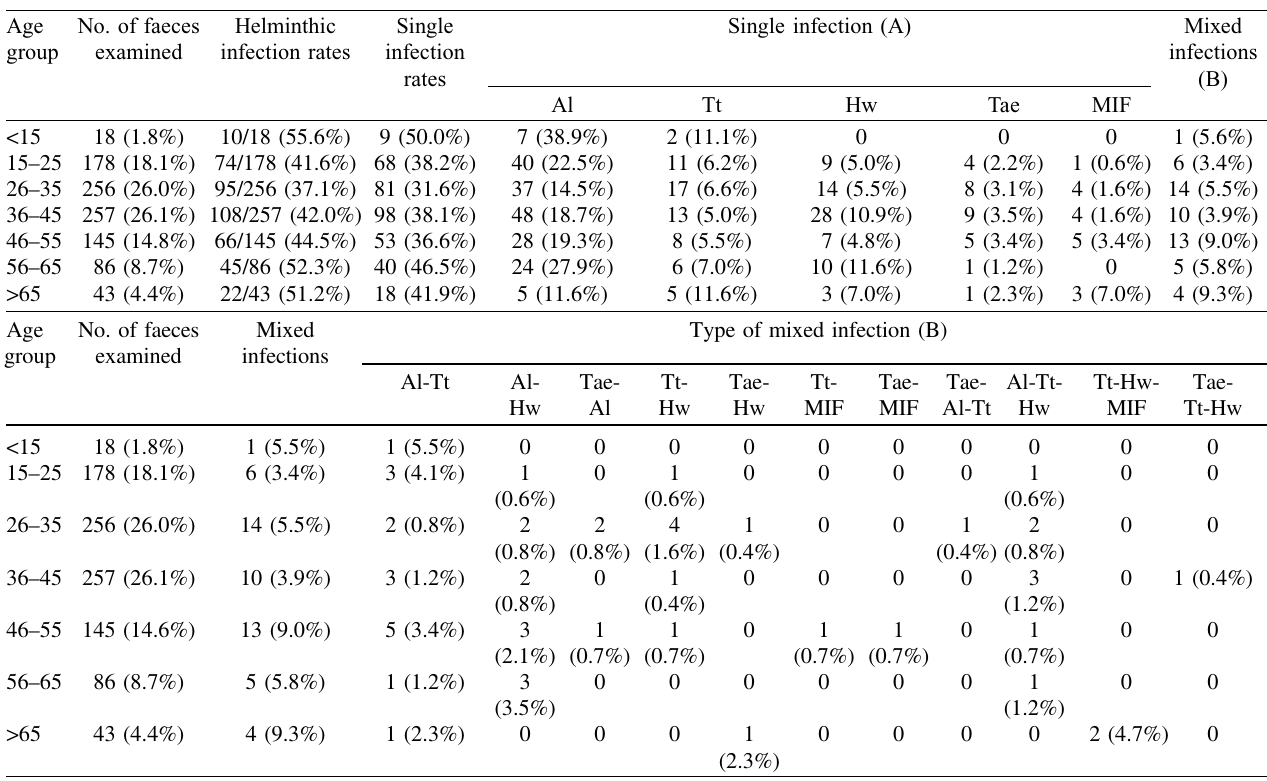
Table 2. Age distribution and prevalence of helminths in population. A and B are single and mixed infection cases, respectively. Age No. of group